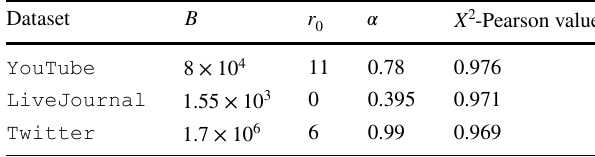
Table 1 Datasets characteristics